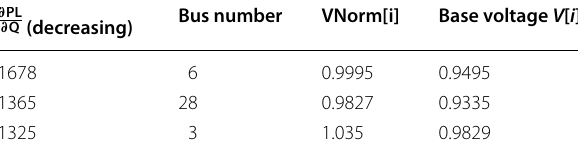
Table 2 Loss sensitivity factors for 33-bus system